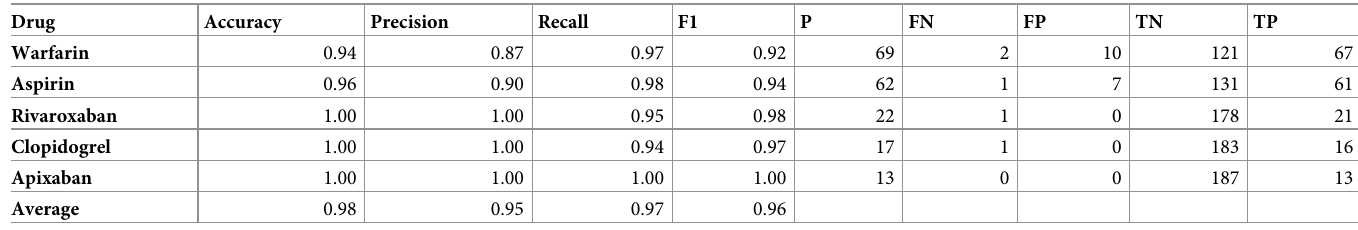
Table 2. Performance of the drug NLP pipeline in manual validation.